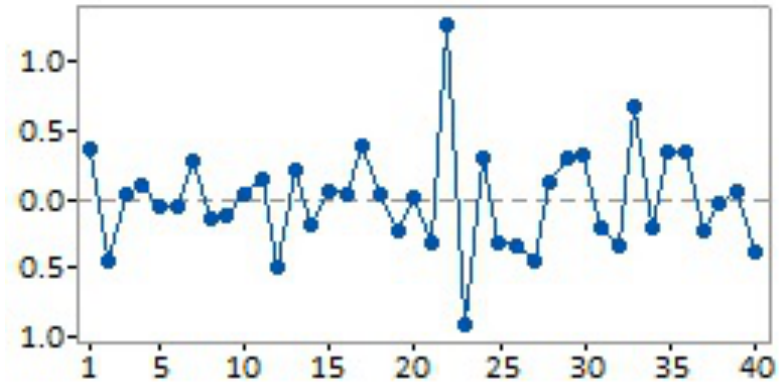
Figure 18. Residuals vs. observation